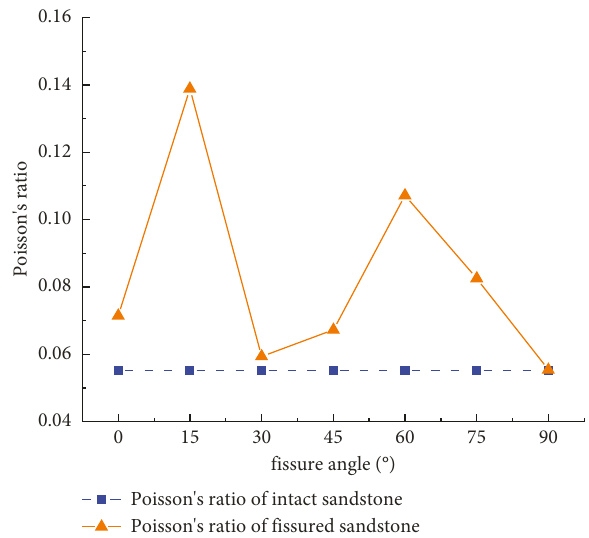
Figure 7: Relationship between Poisson’s ratio and fissure dip in fissured sandstones.